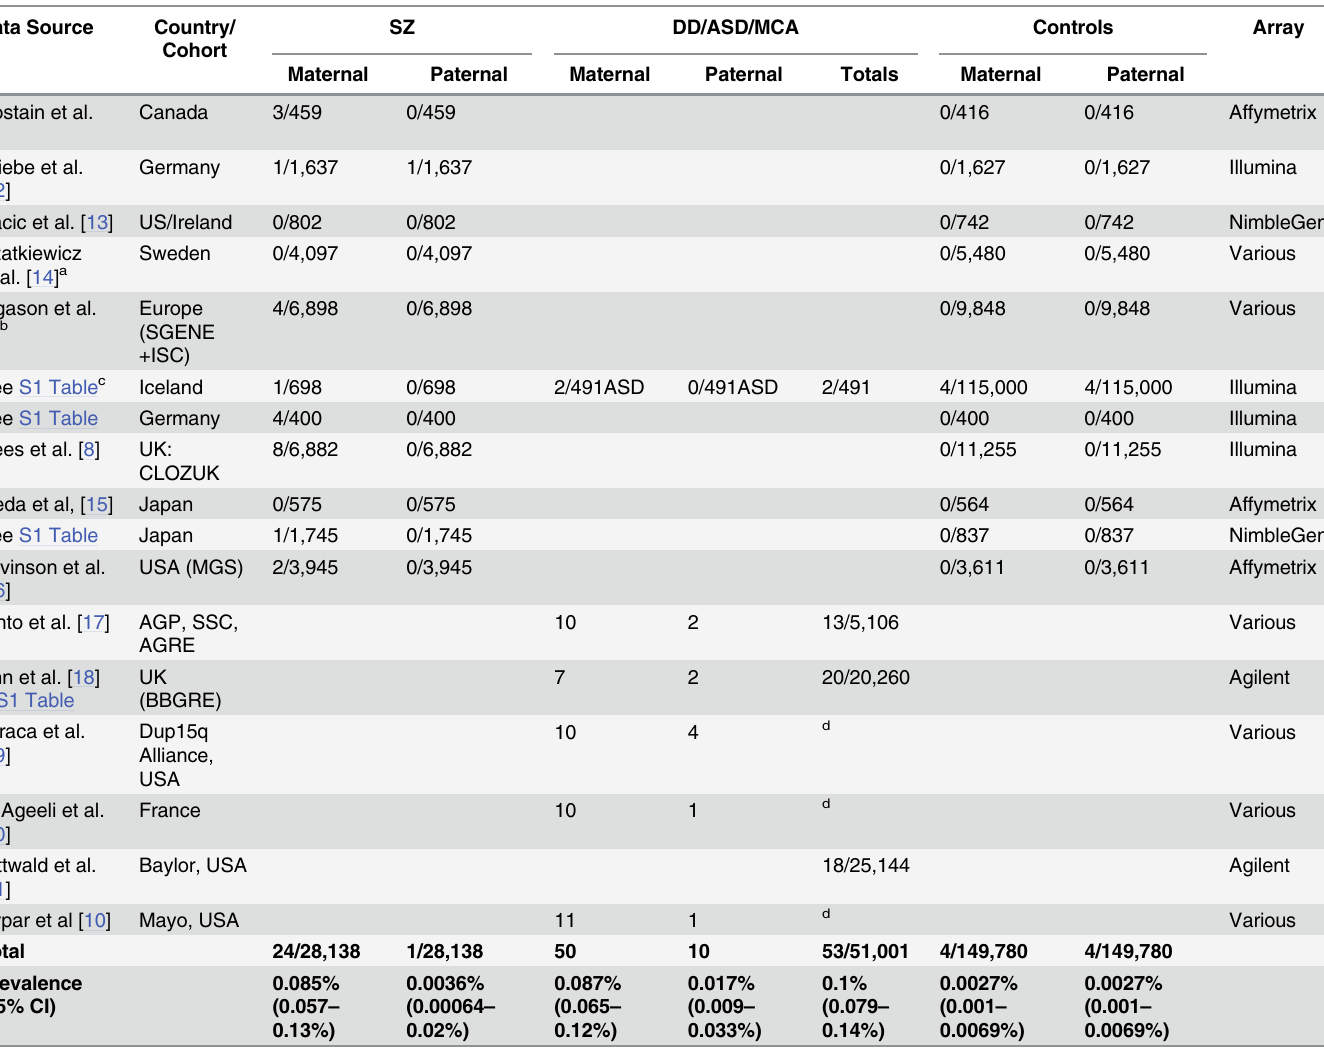
Table 1. Prevalence of 15q11-q13 duplications in disease and control